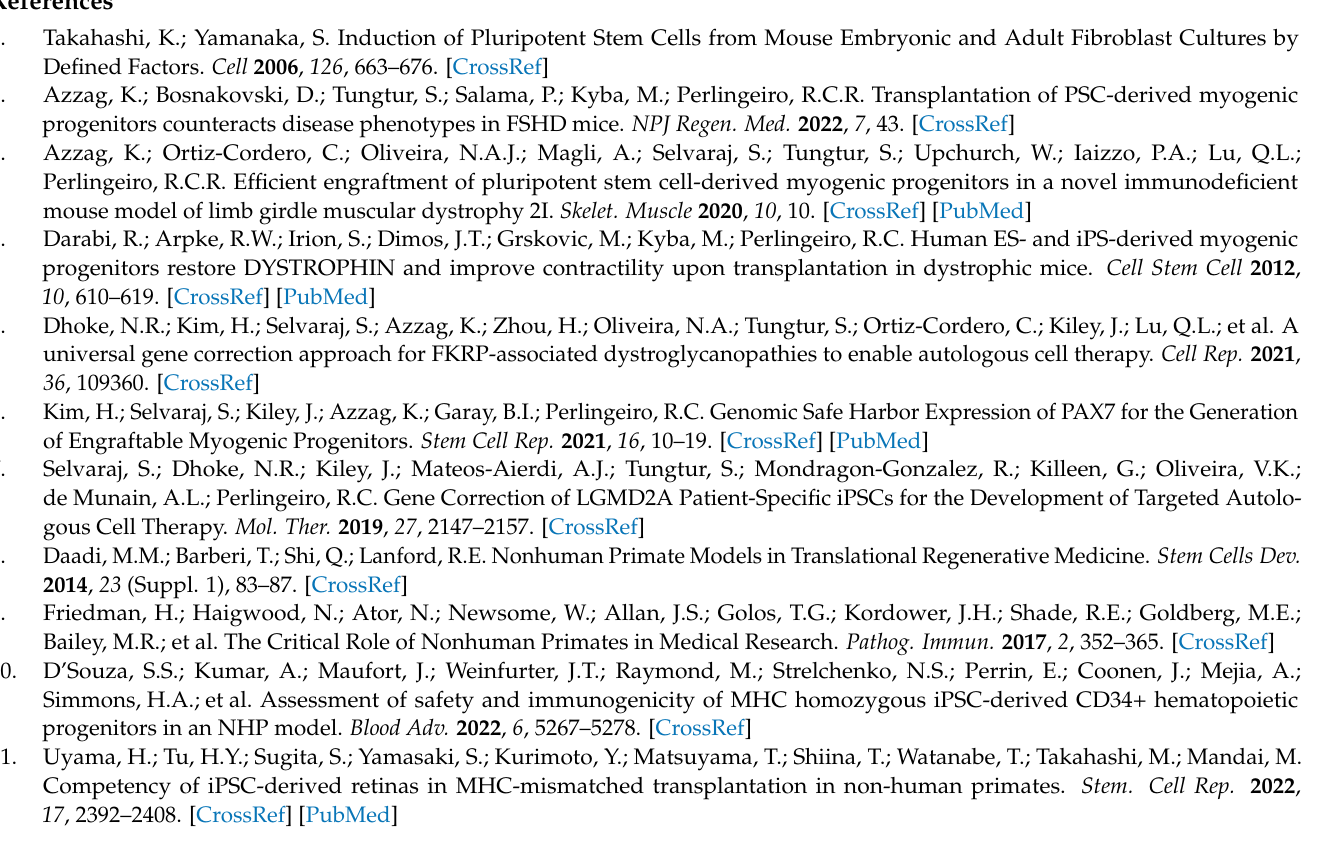
Figure S5: Sensitivity test of RFP signal for RFP-labeled CyMN.2 PAX7+ myogenic progenitors in NHP